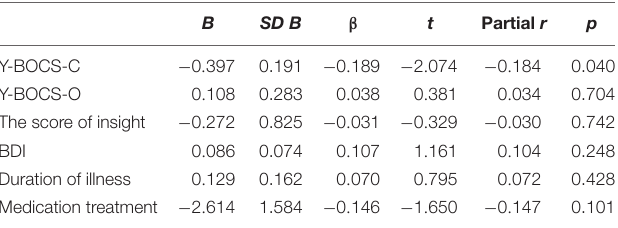
TABLE 4 | Predictors of consummatory pleasure in patients with